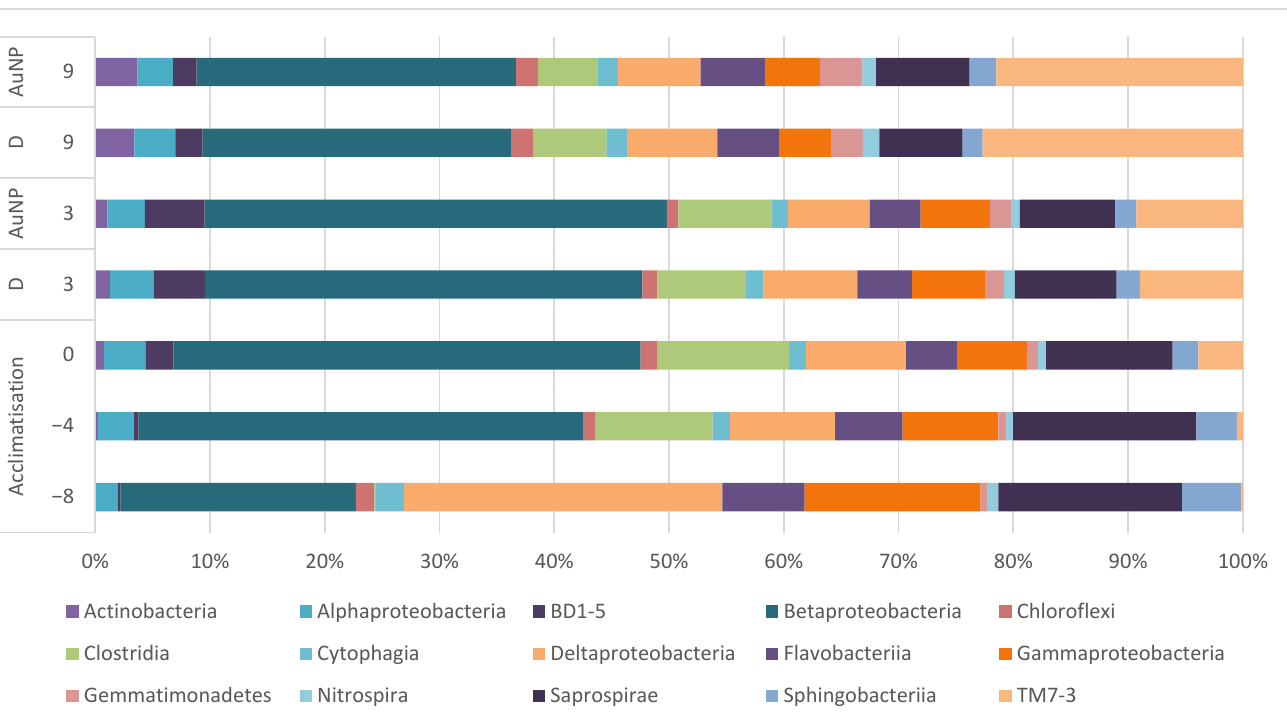
Figure 5. Mean abundance at class level of the sludge: during the experiment course, and before and after the application of dispersant (D) and AuNPs.